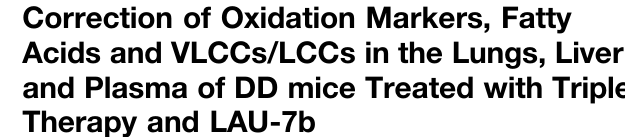
improvement was observed between vehicle treated mice (mean value 321.6, n = 6, SD 30.37) and Triple therapy (mean value 158.9, n = 3, SD 12.21), as well as with their combination (mean value 136, n = 3, SD 40.06). The results indicate a potential bene fi t with combinatory treatment of LAU-7b and Triple therapy, reducing cellular in fi ltration in the airways of DD mice.